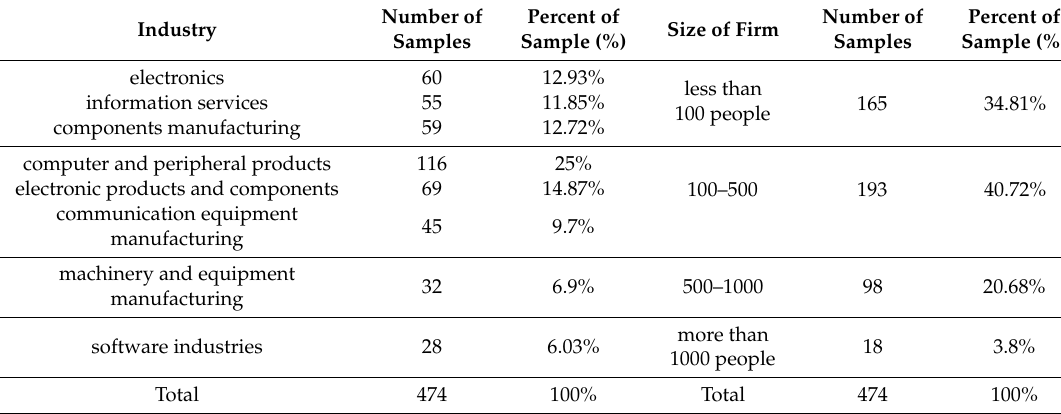
Table 1. Sample distribution by industry classification.